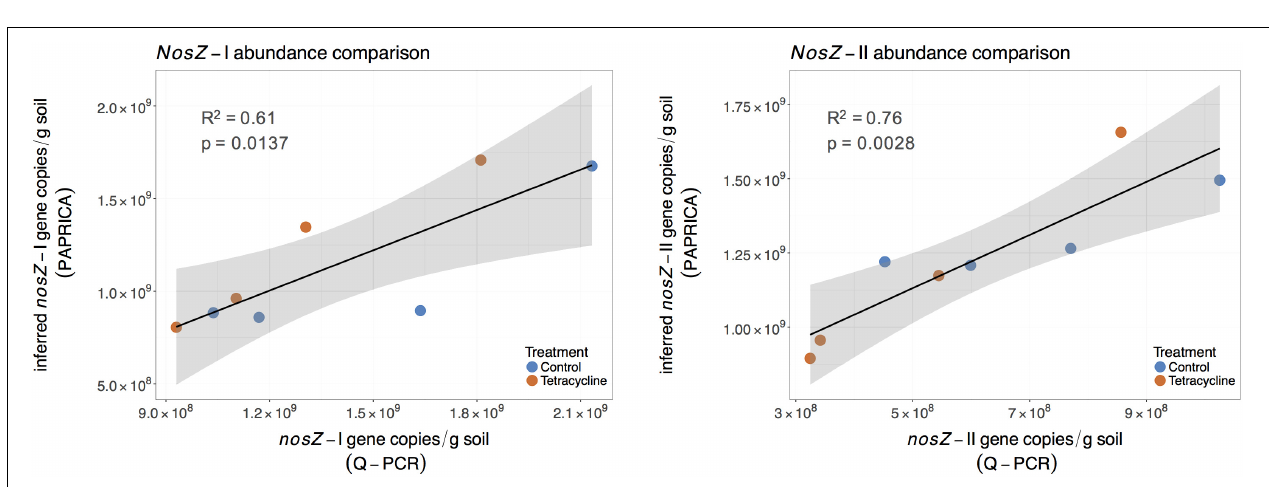
FIGURE 7 | NosZ -I and nosZ -II abundance measured by quantitative PCR (qPCR) in control (blue) and tetracycline (red) samples. Significant difference between control and tetracycline treatment is marked with ∗ (paired t -test, p < 0.05). Each sample is represented by one point. The boxes represent the first and third quartiles, with median value bisecting each box. The whiskers extend to the largest/smallest value, excluding outliers (data beyond 1.5 × inter-quartile range).